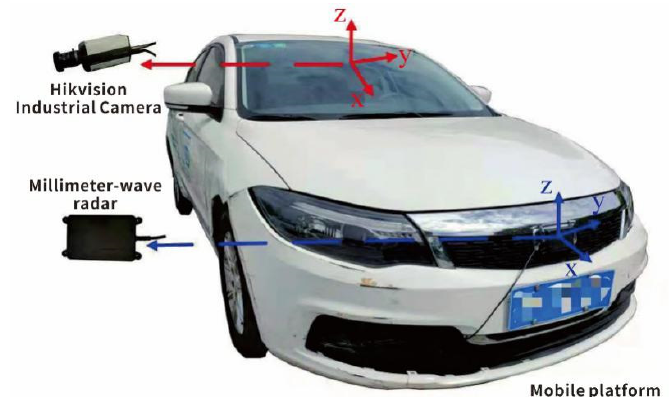
Figure 2. Diagram of sensor installation.